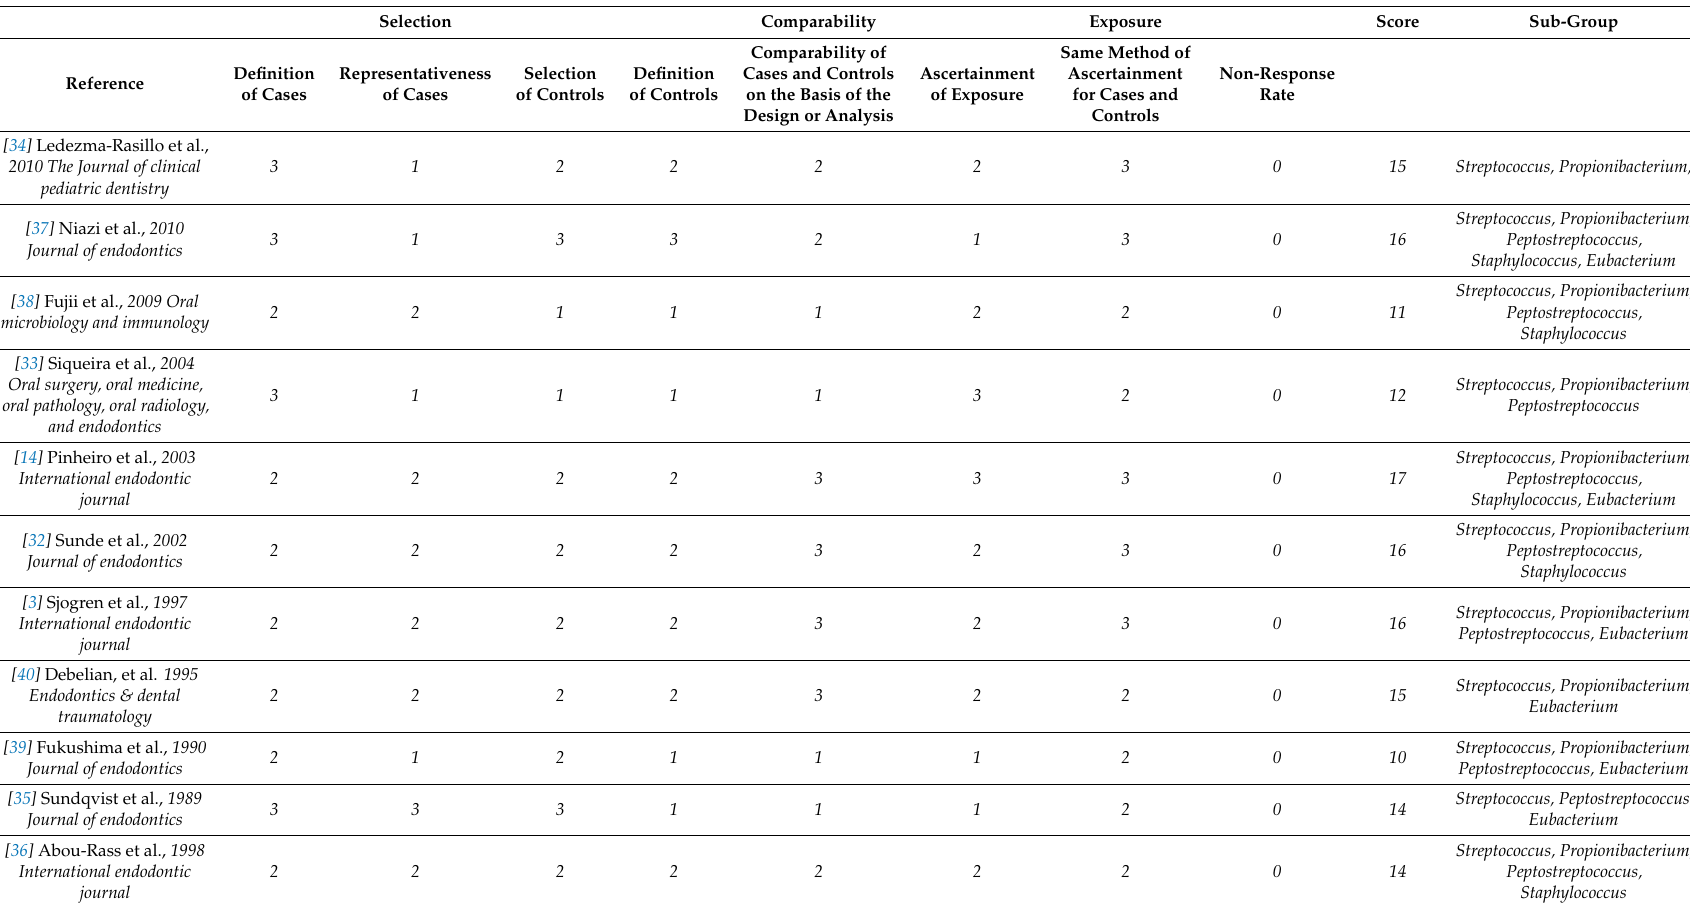
Table 7. Assessment of the risk of bias within the studies (Newcastle–Ottawa scale), with scores 7 to 12 = low quality, 13 to 20 = intermediate quality, and 21 to 24 = high